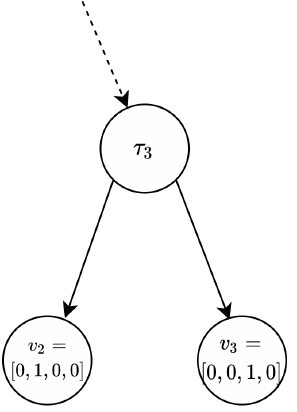
Figure 11. Decision tree with one-hot encoded